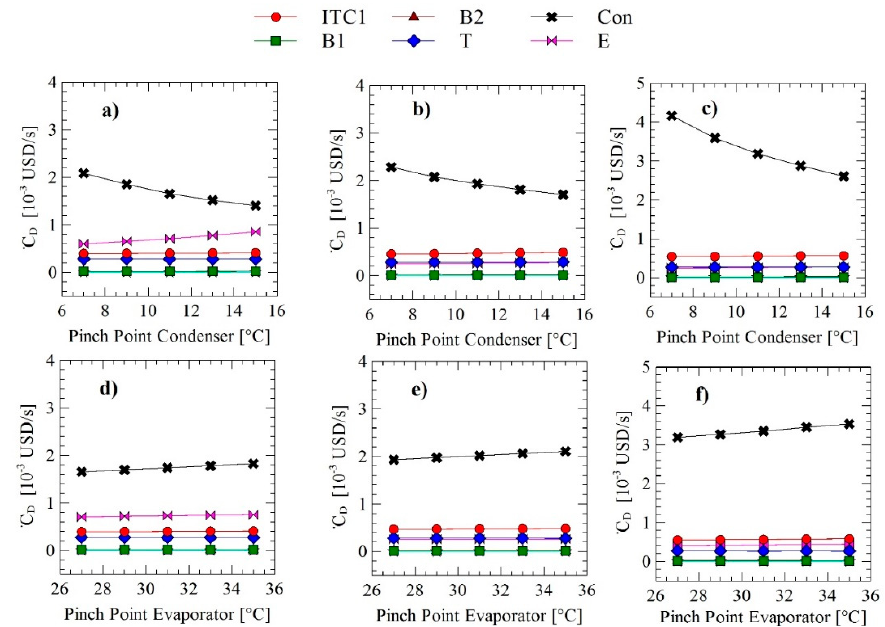
Figure 6. Effect of the condenser and evaporator pinch point on the cost of exergy destroyed using as organic working fluids ( a , d ) toluene, ( b , e ), acetone, ( c , f ) cyclohexane.